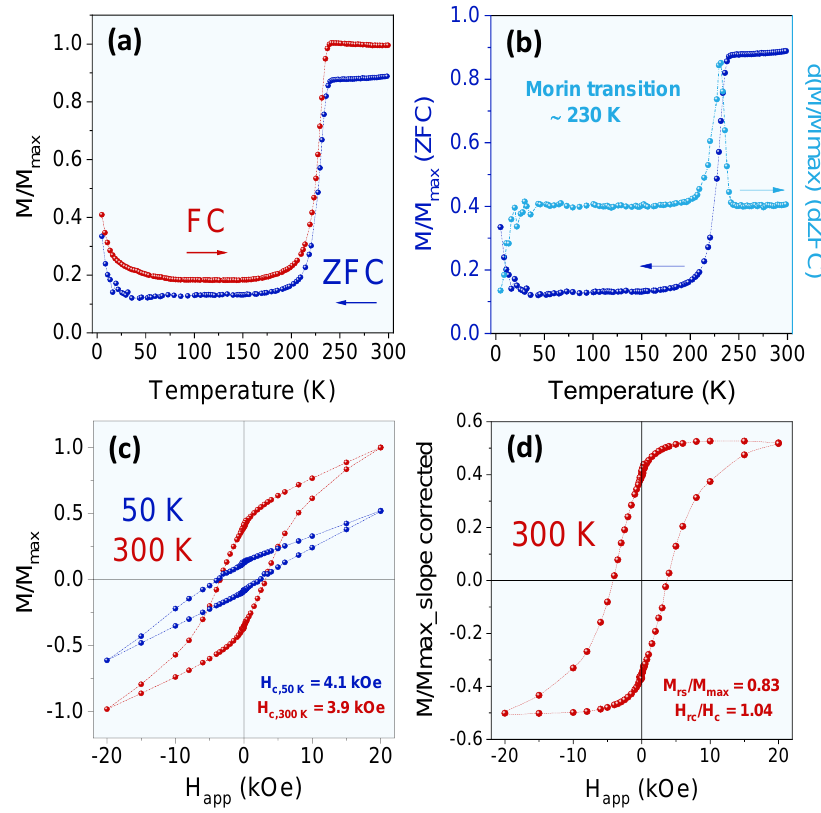
Figure 3. ( a ) ZFC – FC curves recorded between 5 and 300 K and ( b ) ZFC and derivative of ZFC (d(ZFC)) indicating the position of the Morin transition for a nanoparticulated hematite coating. ( c ) Magnetic hysteresis loops acquired at 50 and 300 K under a maximum applied field of 20 kOe. ( d ) Slope corrected magnetic hysteresis loop collected at 300 K.